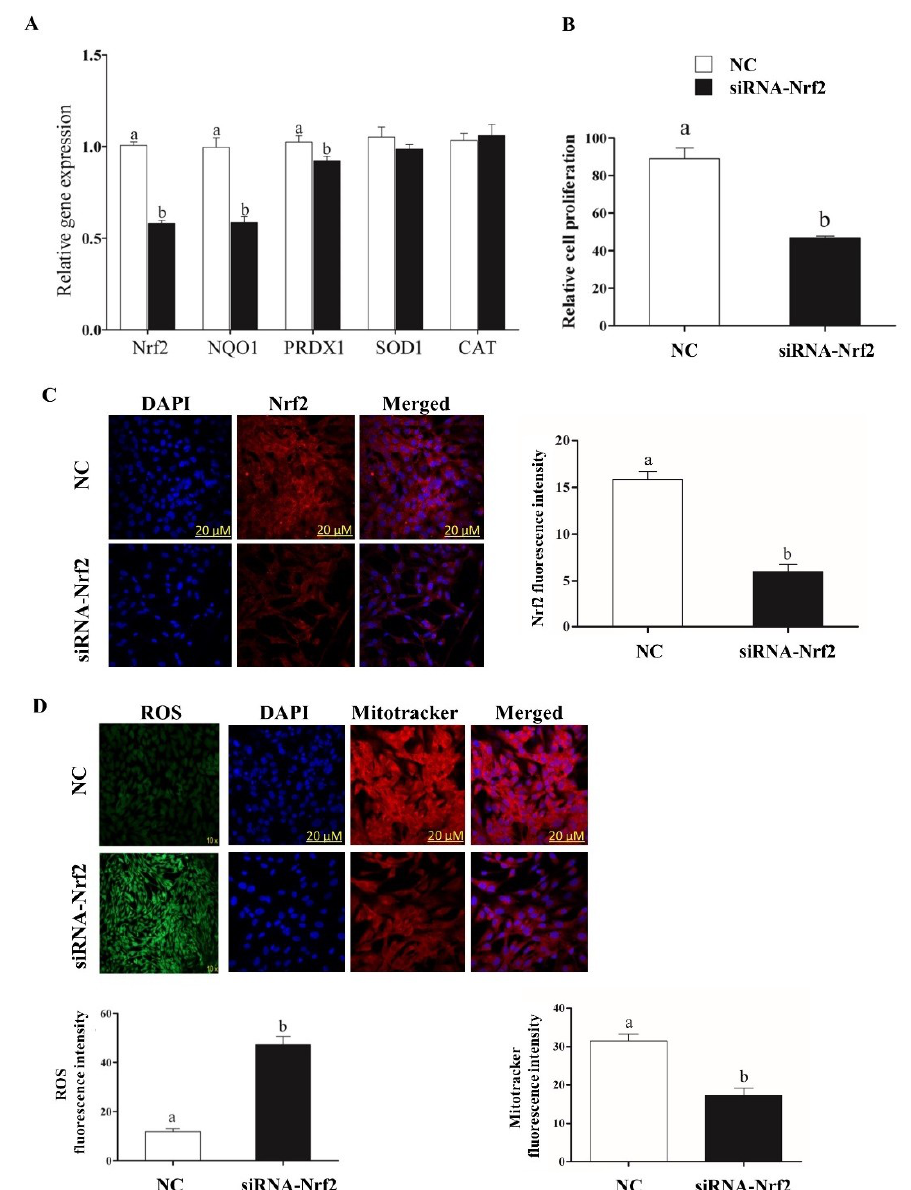
Figure 4. Selective knockdown of Nrf2 reduced cellular mRNA expression level of Nrf2 and its downstream antioxidant genes ( A ). Selective knockdown of Nrf2 reduced bovine granulosa cell proliferation ( B ). Immunocytochemistry of Nrf2 in bovine granulosa cells co-transfected with siRNA targeting the Nrf2 ( C ). Moreover, higher intracellular ROS level and reduced mitochondrial activity ( D ) was observed in Nrf2-knockdown cells compared to the control counterparts. White bars indicate the cells transfected with the NC and the dark bars indicate cells transfected with siRNA targeting Nrf2. Data are presented as mean ± SEM of three independent biological replicates. Bars with different letters (a,b) showed statistically significant differences ( p ˂ 0.05).